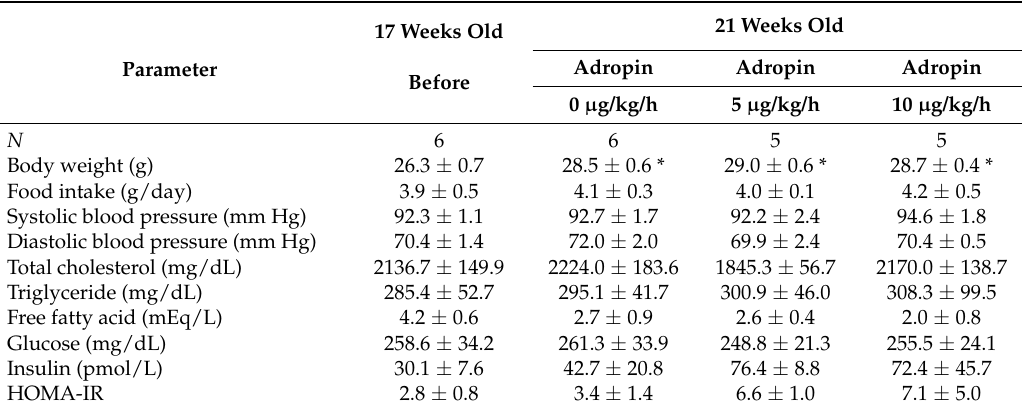
variance followed by Bonferroni’s post hoc test. * p < 0.05 vs. before adropin infusion (17 weeks old).